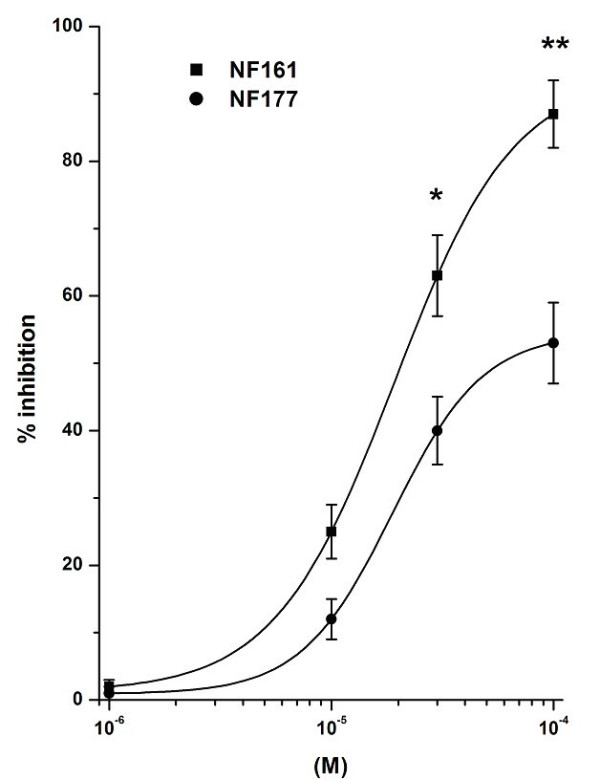
Effects of NF161 and NF177 on FMLP-evoked myeloperoxidase release by PMNs. The results are expressed as percentage inhibition of myeloperoxidase release evoked by 10-8M FMLP in the absence of NF161 and NF177: this release amounted to 31 ± 6%. Data are expressed as means ± SEM; n = 5. Asterisks mark statistically significant inhibition of NF161 versus NF177 (*P < 0.05, **P < 0.01).